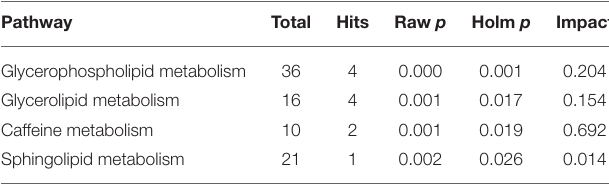
TABLE 3 | Significant pathways as determined by pathway-enrichment analysis. Pathway Total Hits Raw p Holm